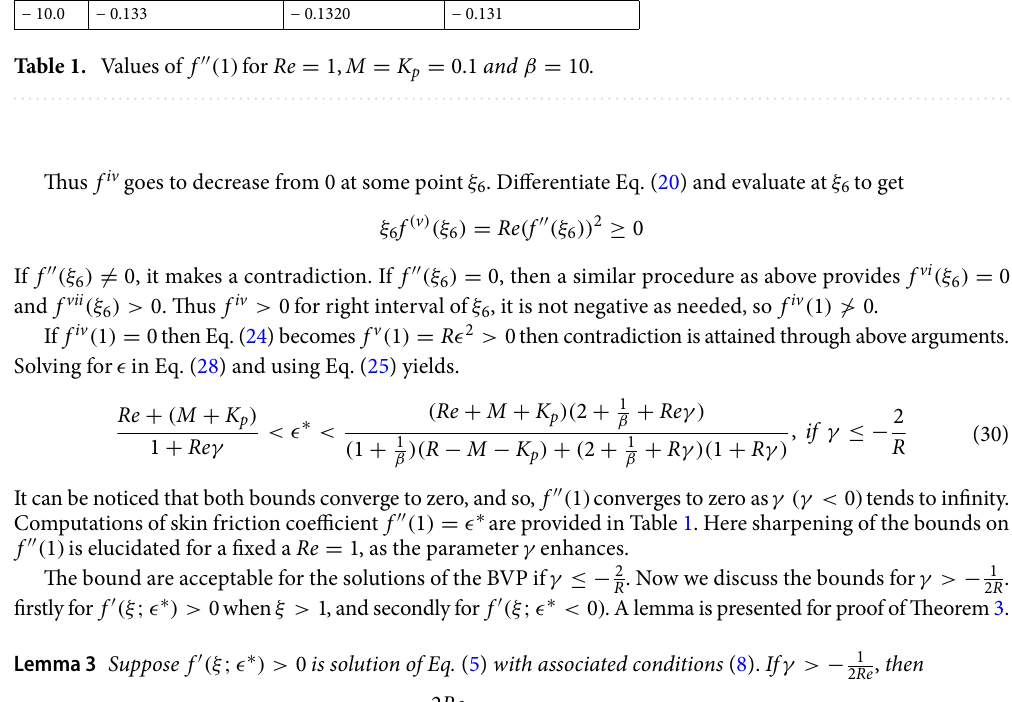
Table 1. Values of f ′′ ( 1 ) for Re